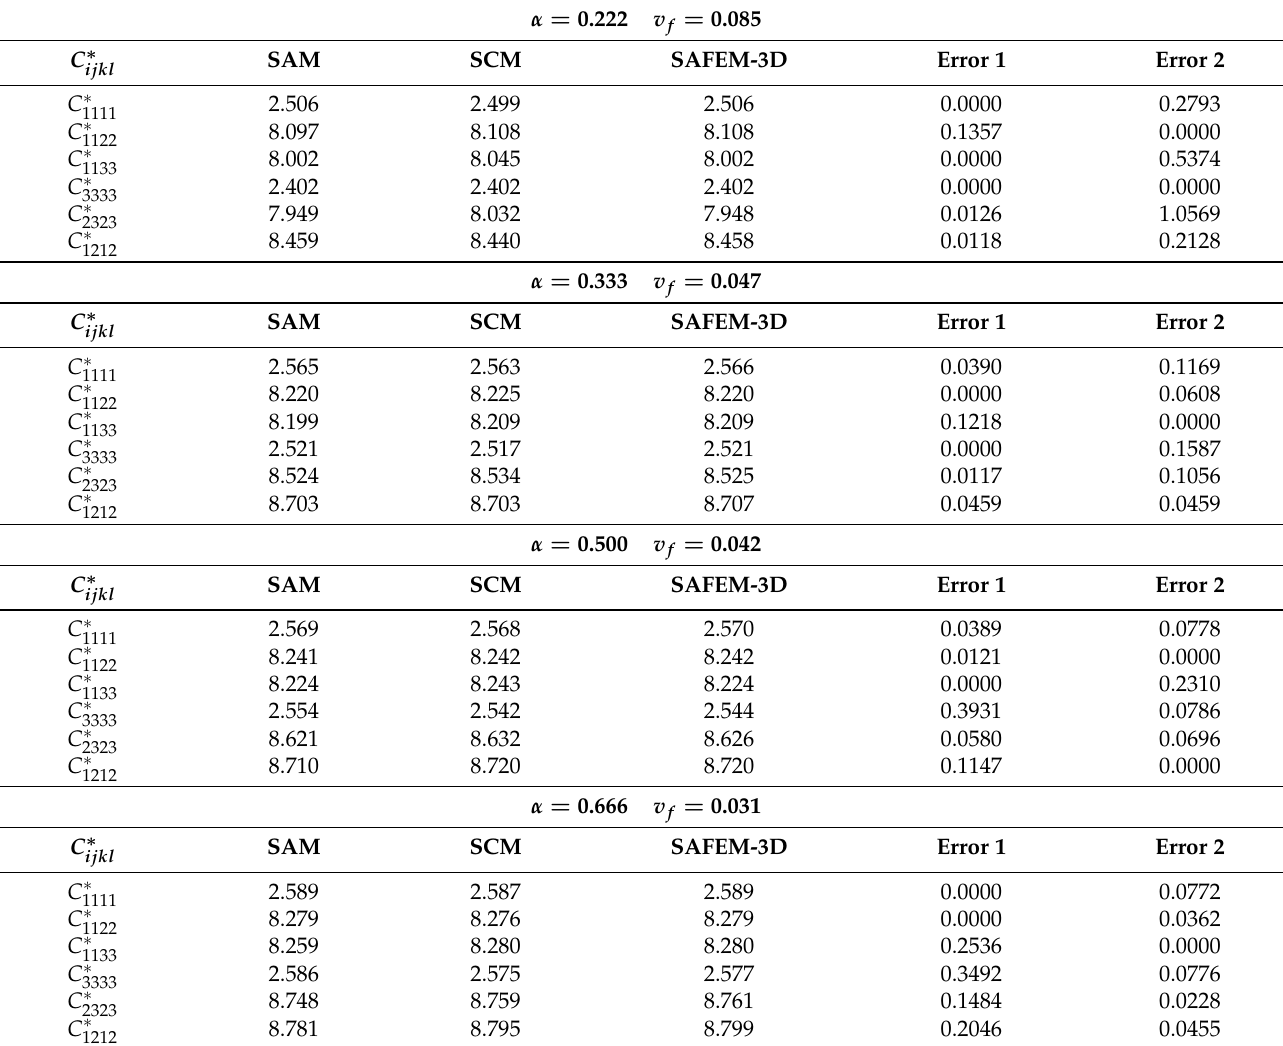
Table 4. Effective elastic coefficients (GPa) for a two-phase FRC reinforced by ellipsoidal inclusions with four different aspect ratios ( α ) and volume fractions ( v f ). Here, the relative errors: Error 1 = (cid:12) Error 2 = (cid:12) ( C ∗ SCM − C ∗ SAFEM − 3D ) /C ∗ SAFEM − 3D